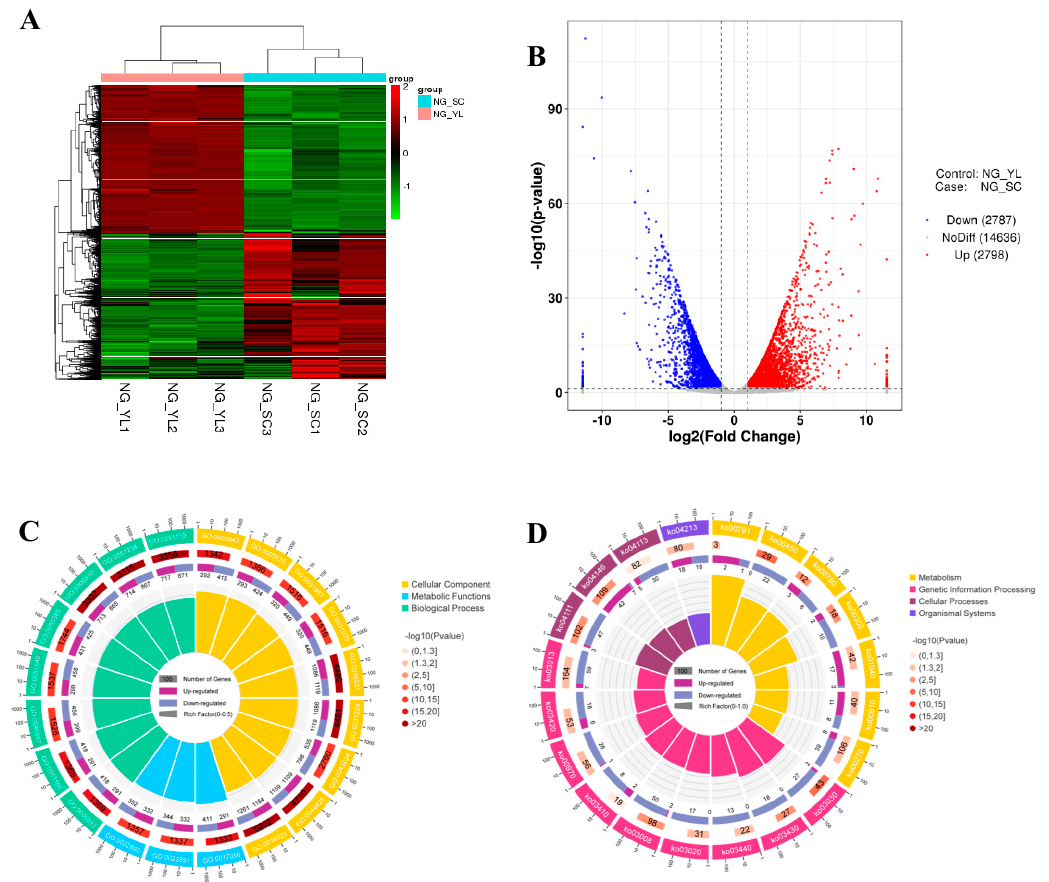
Figure 4. Transcriptome analysis of the SCs and YL in Aureobasidium pullulans NG. ( A ) Clustering analysis of the differentially expressed genes of the SCs and YL. ( B ) Volcano plot of the differentially expressed genes of the SCs and YL. ( C ) Circos plots of GO enrichment analysis of the DEGs. ( D ) Circos plots of KEGG enrichment analysis of the DEGs. From the outer circle to the inner, the top 20 enriched GO terms or KEGG pathways (ring 1), numbers of background genes in the genome (ring 2), numbers of upregulated and downregulated genes (ring 3), and rich factor of the DEGs in the corresponding GO terms or KEGG pathways (ring 4) are represented.